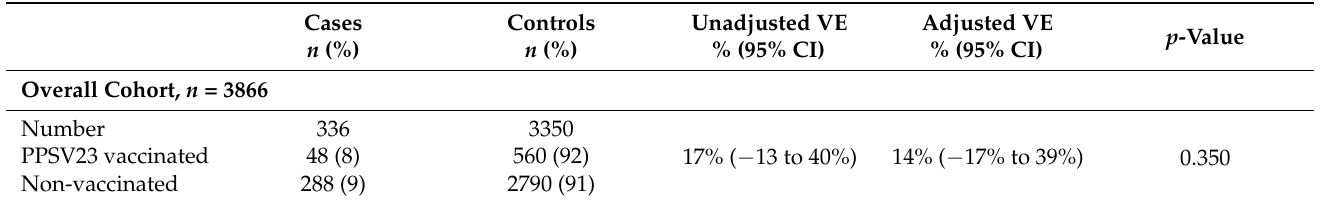
Table 3. Unadjusted and covariate-adjusted PPSV23 vaccine effectiveness for the prevention of hospitalized PPSV23-serotype CAP.